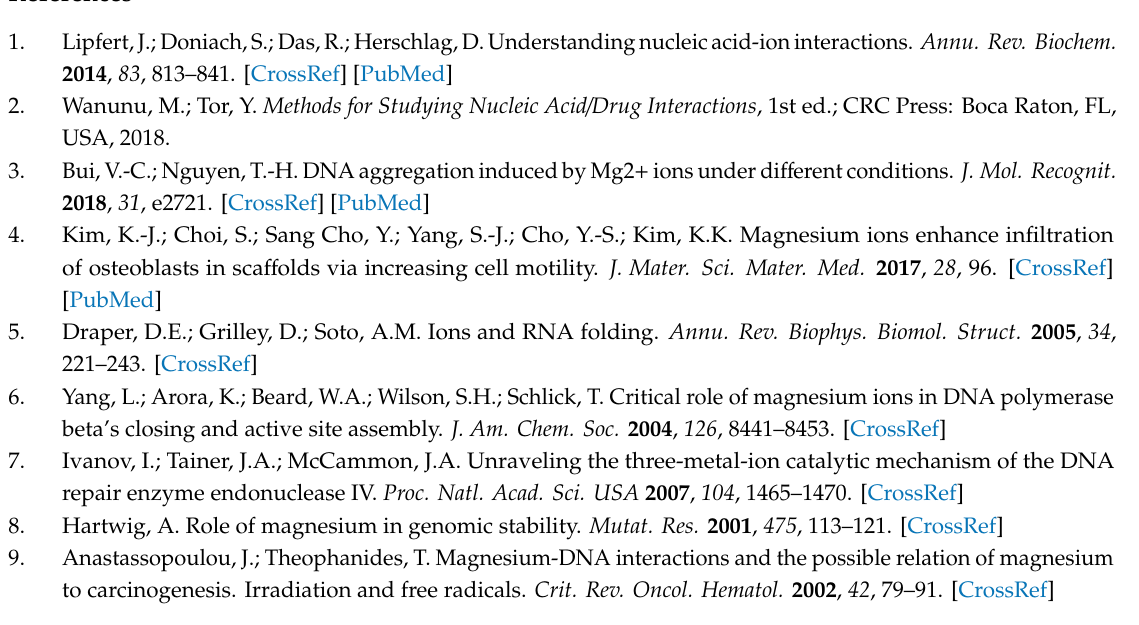
Figure S1 : Examples of full-length gels for DNA bows or linear DNA in the presence of salts at increasing concentrations: ( a ) MgCl 2 , ( b ) MgSO 4 , ( c ) KCl, ( d ) CaCl 2 , ( e ) Al(NO 3 ) 3 , ( f ) Zn(NO 3 ) 2 , and ( g ) AgNO 3 . Green rectangles indicate the cropping areas of the gels for the insets in Figure 3. Figure S2: Examples of full-length gels for DNA bows or linear DNA in the presence of small organic molecules at increasing concentrations: ( a ) guanidine, ( b ) putrescine, ( c ) spermidine, ( d ) ethidium bromide, ( e ) SYBR safe, ( f ) ganciclovir, and ( g ) thiamine. Green rectangles indicate the cropping areas of the gels for the insets in Figure 4. Figure S3: Correlation between u (cid:48) (fitted from relaxed DNA) and u (fitted from bent DNA bows). Error bars represent fitting errors. The blue dashed line indicates u (cid:48) = u